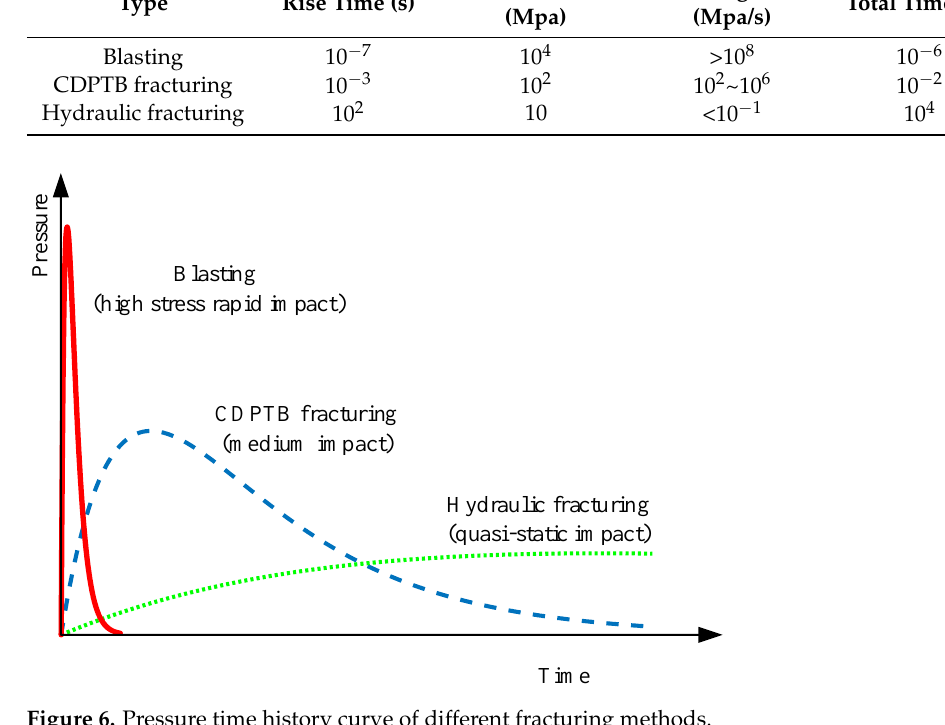
Table 2. Technical parameters of different fracturing methods.